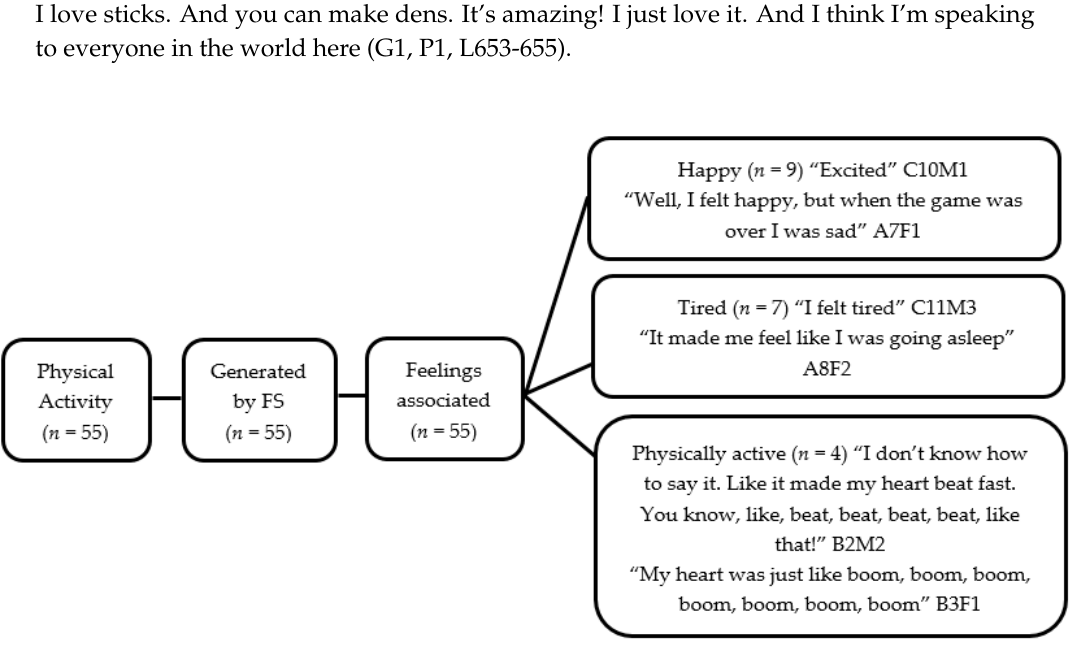
'Dislikes'Natural elements ( n = 6) "I don't like the mud" Age 8 - School D